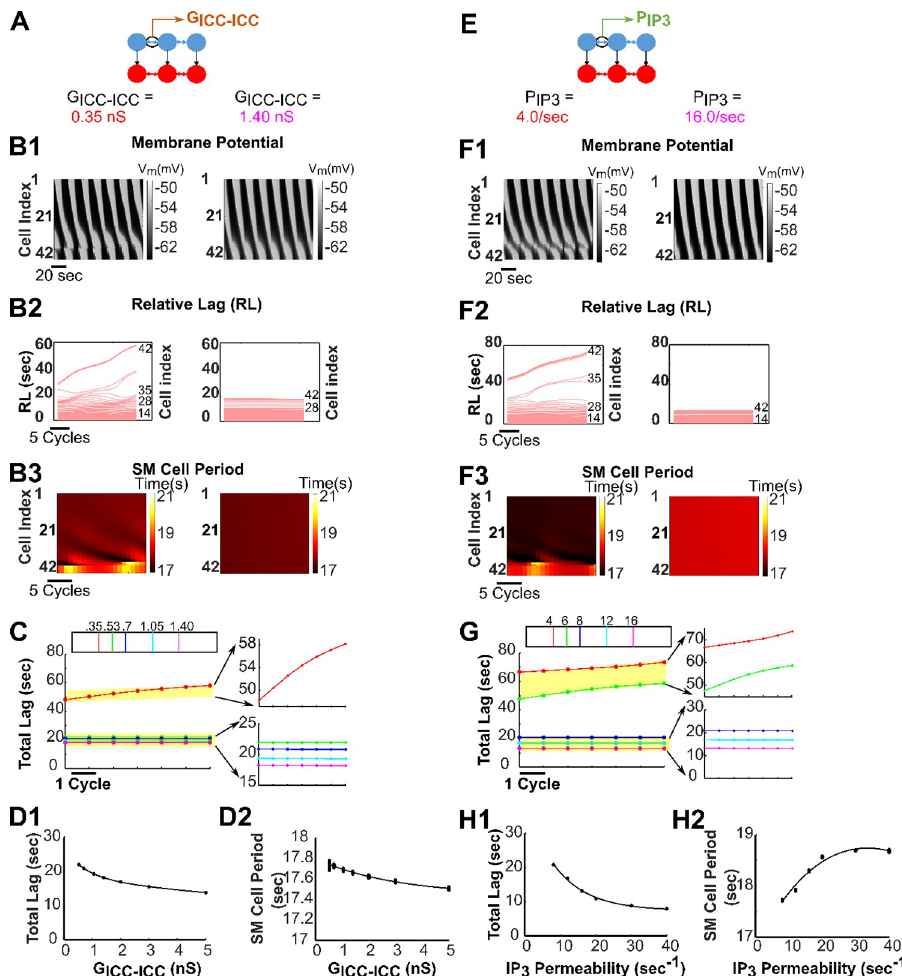
Fig 5. Electrical gap junction and second messenger coupling strengths. The inter-ICC coupling strengths impact GMN entrainment, gastric slow-wave velocity and pacemaker frequency. (A, E) G and P are altered for the ICC−ICC IP 3 simulations in Fig 5B–5D and Fig 5F–5H, respectively. (B) Spatiotemporal map of membrane potential (B1), Relative Lags (B2), and spatiotemporal map of SM Cell Periods (B3 ) for the network when G ICC−ICC = 0.35 nS (left panels, partially entrained) and 1.4 nS (right panels, entrained). (C) The Total Lag for changes in G ICC−ICC is shown for the last 7 cycles of 900-sec simulations for different conductance values (nS) indicated by the color legend. The two distinct classes of responses are enlarged in the right panels (lower ones entrained, upper ones partially entrained). An increase in Total Lag indicates decrease in slow-wave velocity. (F) Spatiotemporal maps of membrane potential (F1), Relative Lags (F2), and spatiotemporal maps of SM Cell Periods (F3) for the network when P IP 3 = 4.0 sec -1 (left panels, partially entrained) and 16.0 sec -1 (right panels, entrained). The spatiotemporal membrane potential diagrams are shown for the last 120 seconds of the respective simulation, whereas the Relative Lag and the SM Cell Period diagrams are shown for the last 20 cycles of the respective simulation. (G) The Total Lag for changes in P IP 3 is shown for the last 7 cycles of 900-sec simulations for different conductance values (nS) indicated by the color legend. (D, H) For several networks, the mean Total Lag (odd numbered panels) and the SM Cell Period (even numbered panels) of the last 7 cycles for each network with respect to its G ICC−ICC and P IP 3 can be fit by individual exponential function, respectively. For increasing (cid:0) x = b 1 þ a (cid:0) x = b 2 , where a 1 = 8.65, β 1 = 0.75, a 2 = 18.23, β 2 = 17.87) has values of G ICC−ICC , an exponential fit ( y ¼ a 1 e 2 e been drawn along the mean value of Total Lag and for increasing values of P , another exponential fit IP 3 (cid:0) x = b 1 þ a (cid:0) x = b 2 , where a 1 = 7.44, β 1 = 1.70e5, a 2 = 32.07, β 2 = 9.37) has been drawn along the mean values of ( y ¼ a 1 e 2 e Total Lag . Partially entrained networks have not been considered for equation fitting. For SM Cell Period calculation, the last cell (42 nd cell) has been considered as the representative cell of the network. An increase in Total Lag indicates decrease in slow-wave velocity while a decrease in SM Cell Period indicates increase in pacemaking